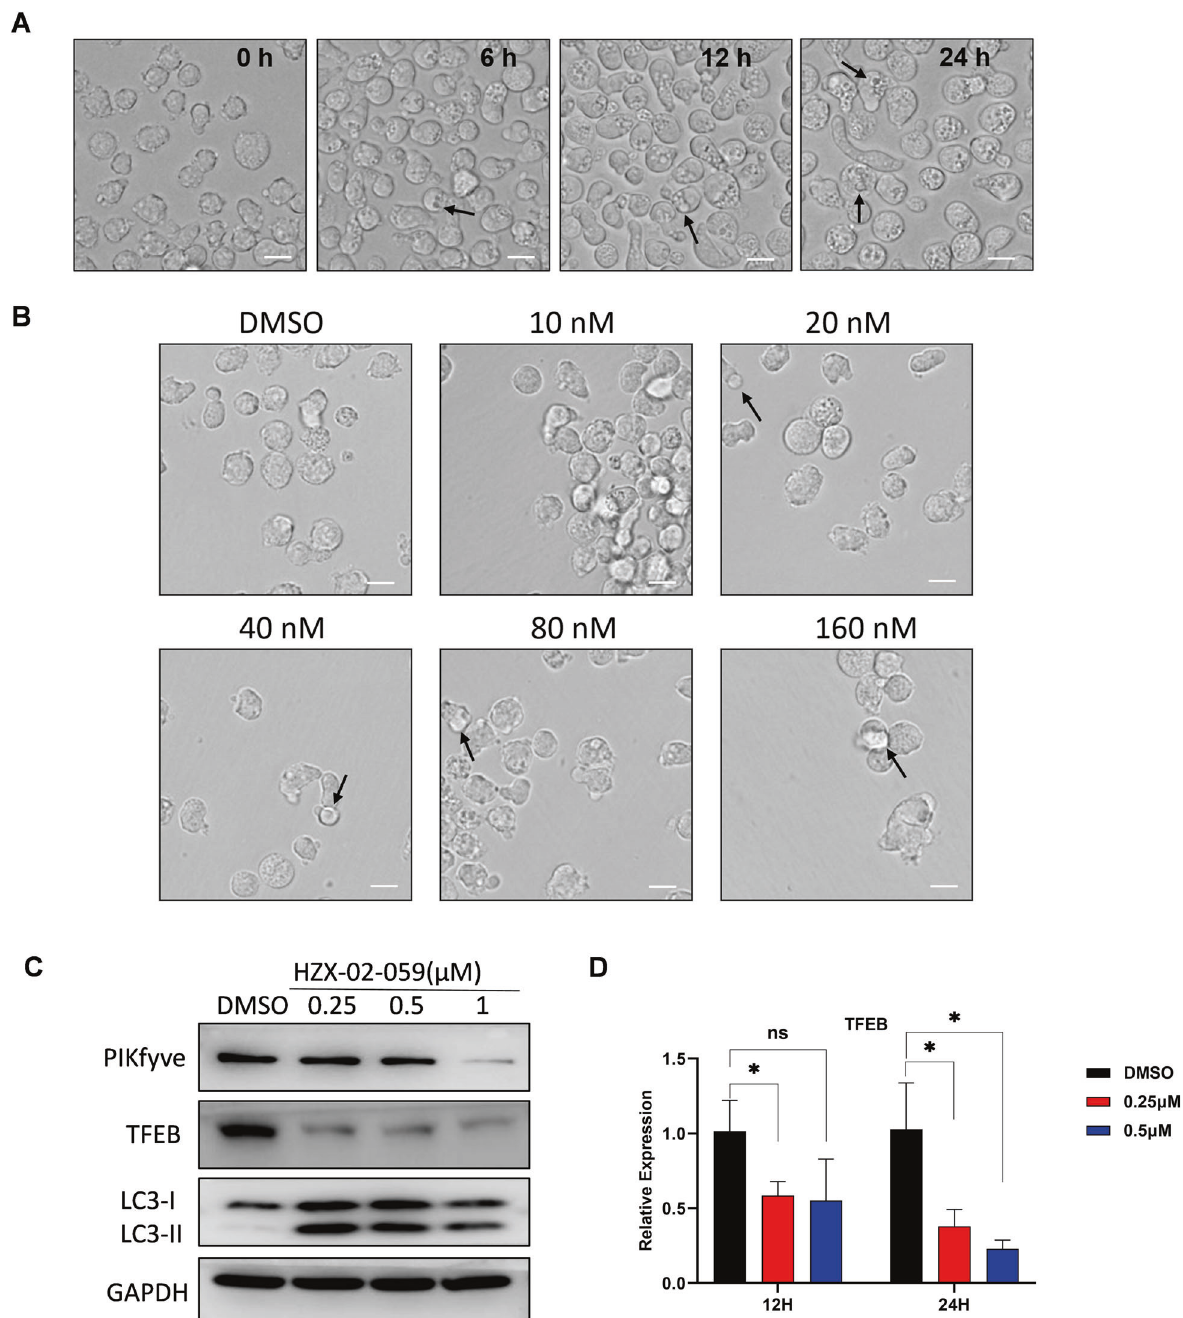
Fig. 4 HZX-02-059 triggers non-apoptotic cell death of methuosis as a result of PIKfyve/TFEB inhibition. A Morphological changes in cytoplasm and irregular variations of the cell membrane after 6, 12, 24 h treatment with 2 μ M HZX-02-059 using an optical microscope. Scale bars = 20 μ m. B Intracellular vesicles were not degraded until cell death even though exposed to nanomole concentration of HZX-02-059 for consecutive 5 days. C Protein levels of LC3, PIKfyve, and TFEB were evaluated by western blotting after the drug ’ s administration. GAPDH was served as a loading control. D Real-time PCR analysis was performed to validate the expression of TFEB in Will-2 cells treated with HZX-02-059 for 12 h and 24 h. The reaction was carried out in triplicate and relative expression levels were calculated as 2 − △△ CT after normalization to β -actin. Values indicate mean ± S.D. for at least three independent experiments performed in triplicate (* P < optimizing alternative therapeutic strategies for patients with translocation, leading to the overexpression of BCL-2 and MYC, DHL, especially those with more lactate dehydrogenase (LDH), respectively. The overexpression of MYC generates the uncon- higher international prognostic index (IPI) scores, and additional trolled proliferation ability, while BCL-2 renders the cells lose the in fi ltration, are urgently needed. In this pre-clinical study, we fi rstly brake for apoptotic responses, which both contribute to a perfect con fi rm the cytotoxicity activity of HZX-02-059, a novel PIKfyve storm for carcinogenesis [26, 27]. Increasing evidences suggest and tubulin dual-target inhibitor, against DHL cell lines in vitro and that patients with DHL are more likely to experience poor survival in vivo, which might further provide evidence that HZX-02-059 under the standard treatment of R-CHOP [28]. Therefore,